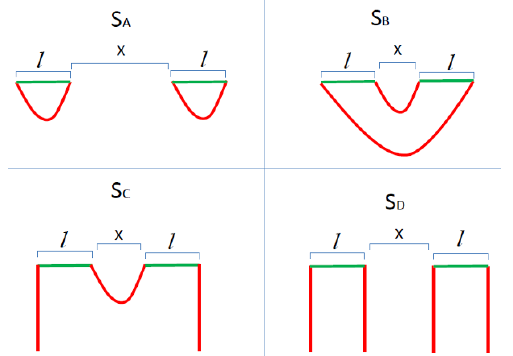
Figure 6 . Illustration of the four di(cid:11)er- ent minimal area surfaces for two strips of equal length ‘ separated by a distance x in the thermal-AdS background. S A corresponds to minimal area surface for small ‘ and large x , S B corresponds to minimal area surface for small ‘ and small x , S c corresponds to minimal area surface for large ‘ and small x and S D corre- sponds to minimal area surface for large ‘ and large x .